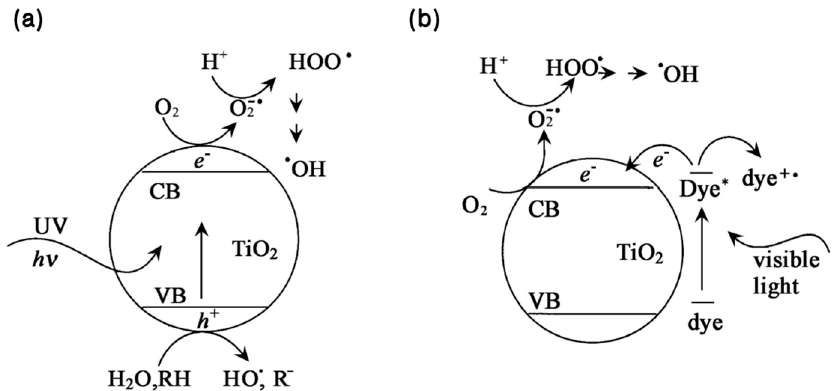
Figure 1. Reaction mechanism diagram of TiO 2 photocatalytic oxidation under UV ( a ) and visible light ( b ) [47]. Reprinted with permission from Ref. [47].